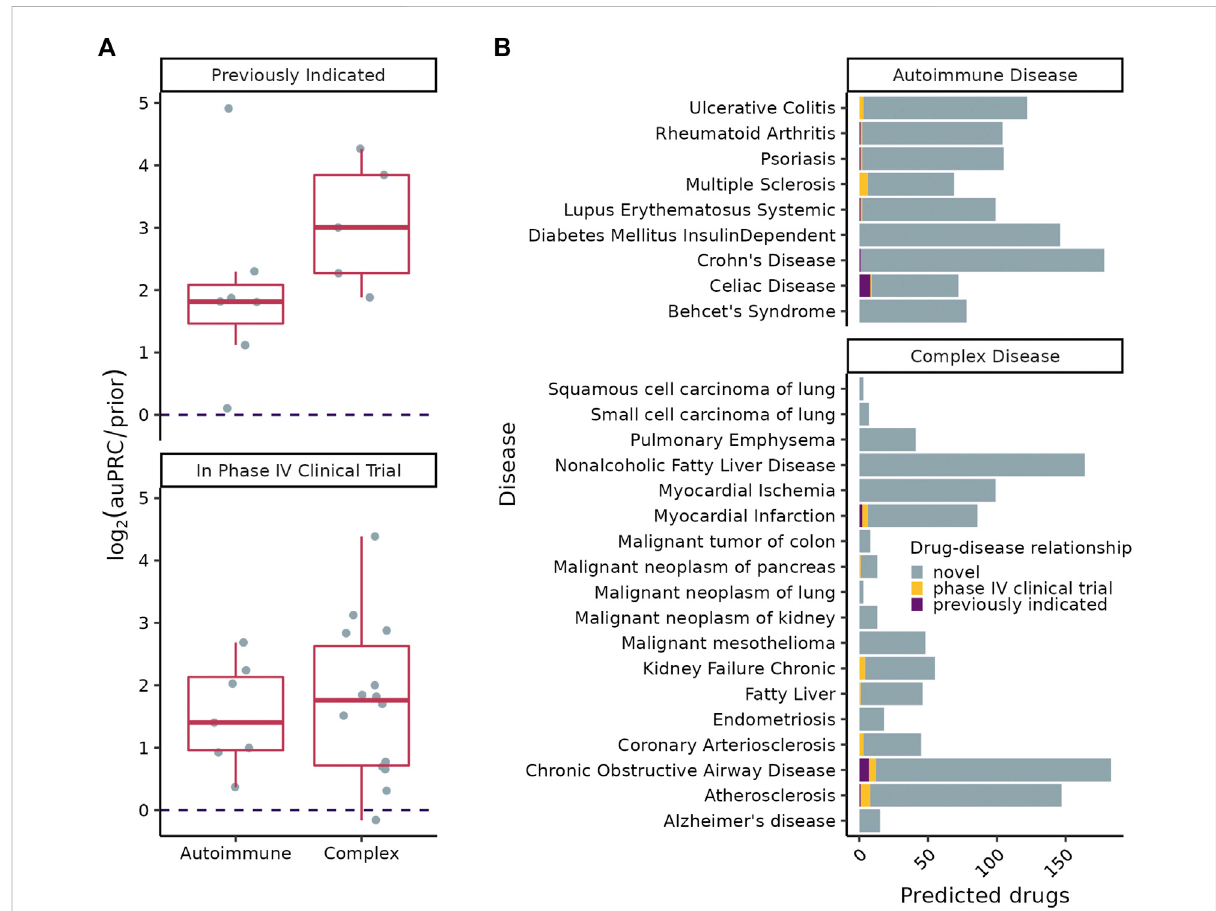
FIGURE 5 (A) log 2 ( auPRC / prior ) of SAveRUNNER predictions using drugs previously indicated for the disease (top) or drugs ever in Phase IV clinical trials for a disease (bottom) as positive examples. The dotted line is at log 2 ( auPRC / prior ) (cid:2) 0 . log 2 ( auPRC / prior ) > 0 denotes predictions better